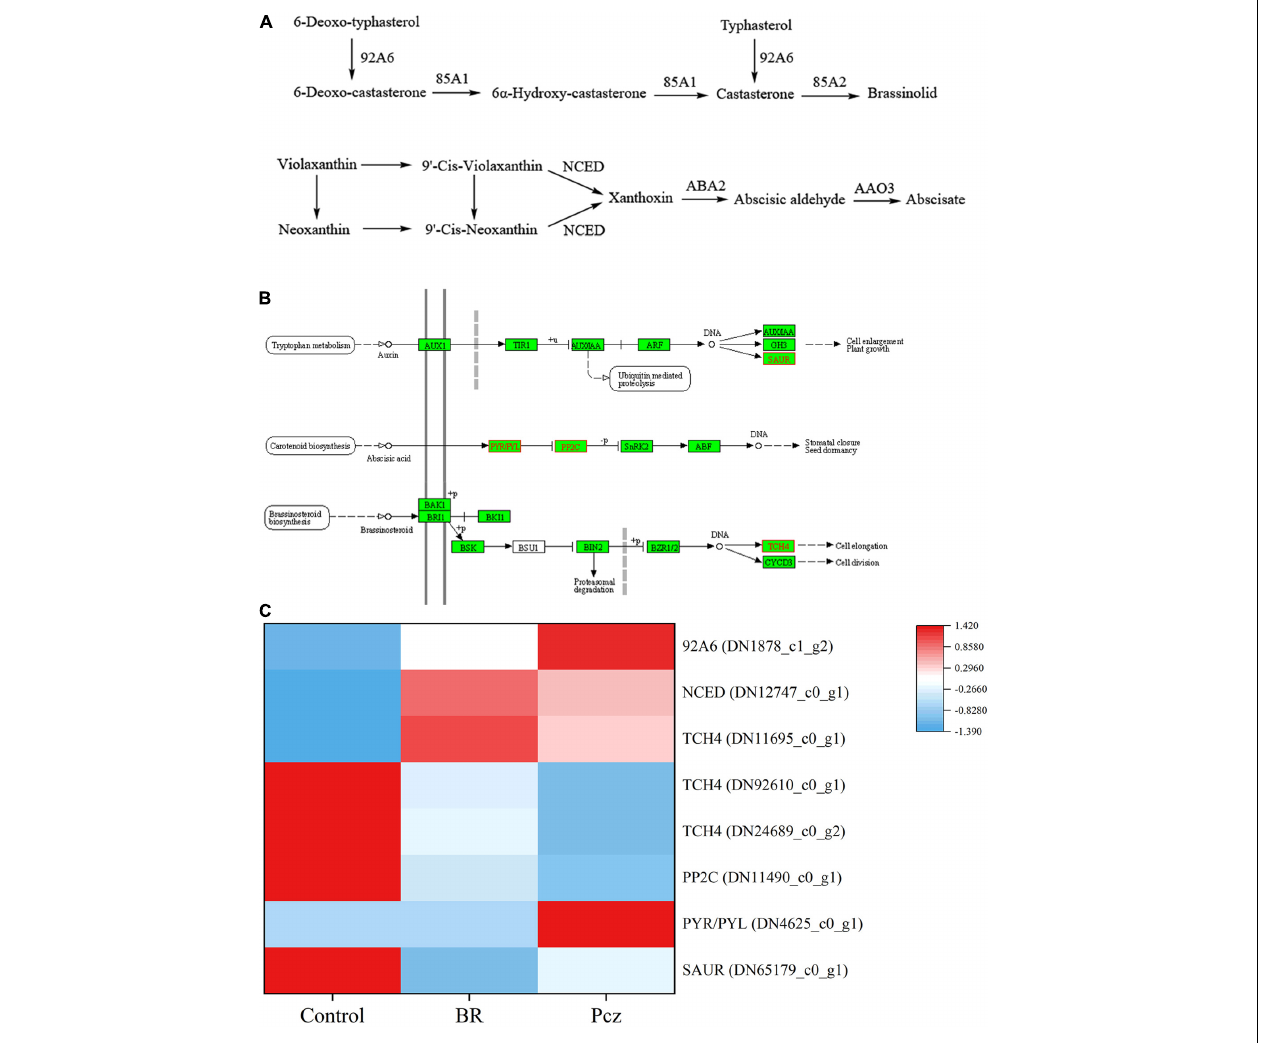
FIGURE 9 | Analysis of differentially expressed levels related to hormone synthesis and signaling pathway in bulbil of P. ternata under BR and Pcz treatments. (A) The hormone synthesis pathway. (B) The hormone signaling pathway. (C) The expression levels of genes related to the hormone synthesis and signaling pathway. Blue indicates a lower expression level, whereas red indicates a higher expression level. All data showed the average mean of three biological